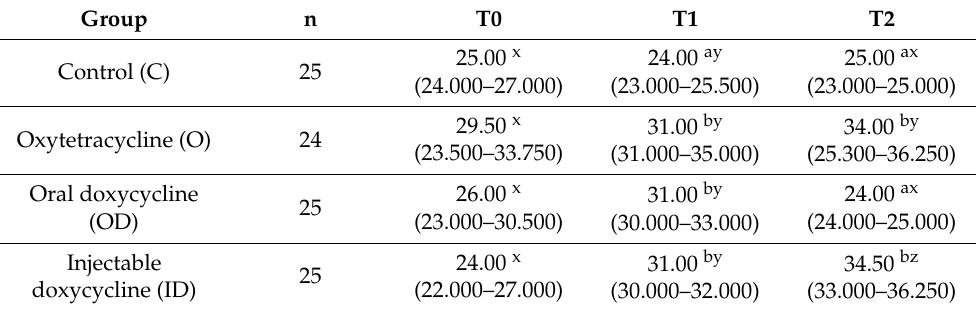
Table 1. qPCR results (Cq median value and 25th and 75th percentile values) of the lambs that were treated with oral doxycycline (OD), injectable doxycycline (ID), oxytetracycline (O), and untreated animals belonging to the control group (C) in the three moments that were analyzed: before treatment (T0), 12 days after the beginning of the treatment (T1), and 45 days after the beginning of the treatment